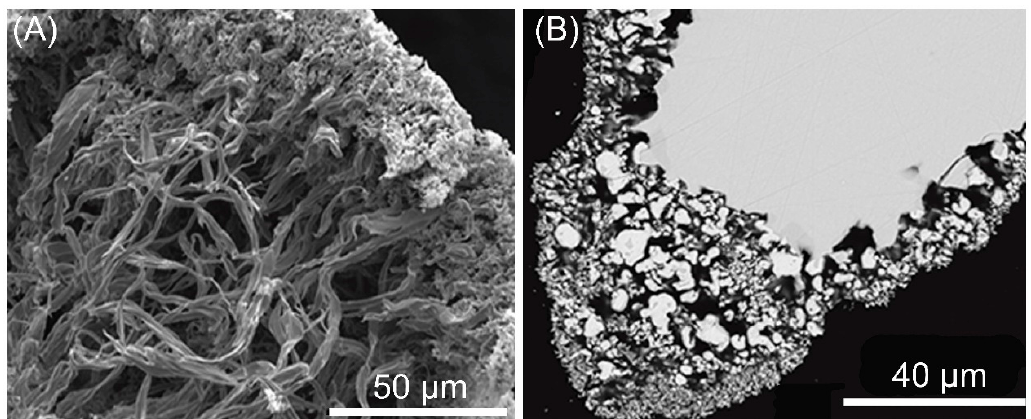
Figure 8. ( A ) Secondary electron image showing the highly porous Au–Ag alloy in the shape of filaments. ( B ) Backscattered electron image of cross section of partially-reacted krennerite grains showing larger Au–Ag alloy particles coexisting with fine-grained Au–Ag alloy in the resultant gold rim (imaged by W. Xu).